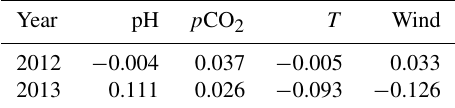
Table 2. Correlations between tide height and four parameters dur- ing the non-upwelling seasons (2012,